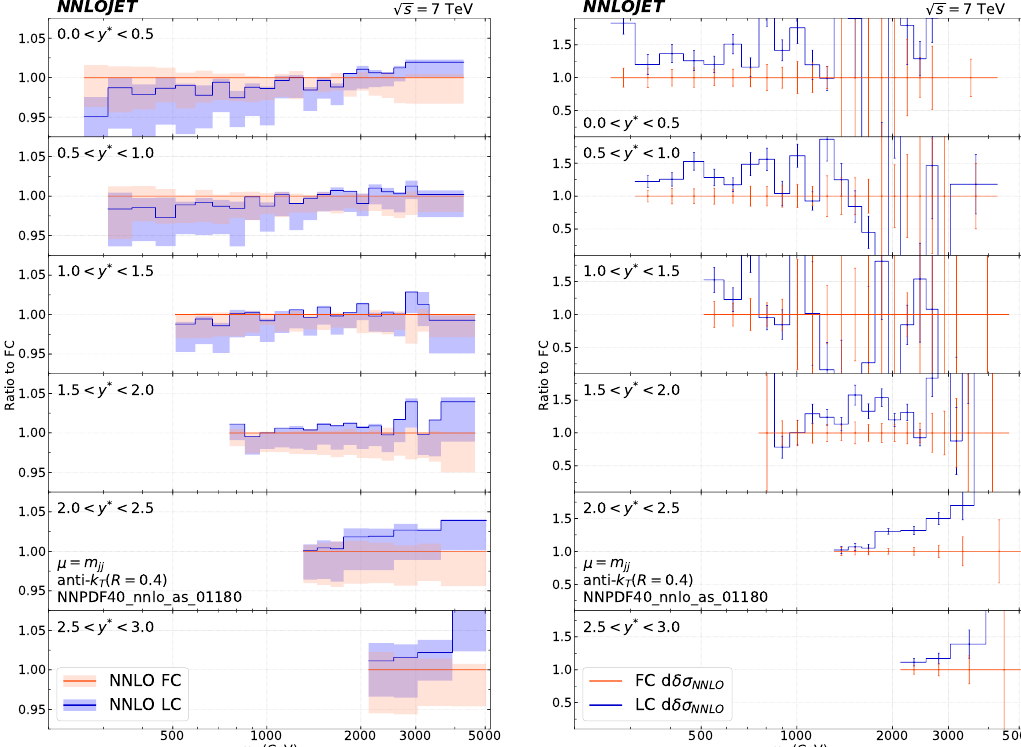
Figure 10 . Comparison of LC (blue) and FC (red) predictions of the dijet cross section as function of m jj for all the considered y ∗ slices, normalized to the FC prediction. Left: NNLO cross section, right: NNLO